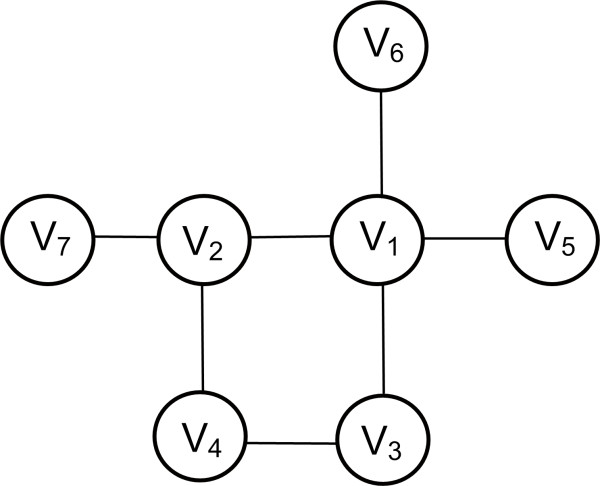
Eccentricity Centrality. V1: 4 × 1, 2 × 2; V1 accesses 4 nodes (V2, V3, V5, V6) with step 1 and 2 nodes (V4, V7) with step 2. The step represents the shortest path. The maximum shortest path dmax = 2. V2: 3 × 1, 3 × 2; Similarly V2 accesses 3 nodes (V4, V7, V1) with step 1 and 3 nodes (V3, V5, V6) with step 2. The maximum shortest path dmax = 2. V3: 2 × 1, 3 × 2, 1 × 3; Similarly V3 accesses 2 nodes (V1, V4) with step 1, 3 nodes (V2, V5, V6) and one node (V7) with step 3. The maximum shortest path dmax = 3. V4: 2 × 1, 2 × 2, 2 × 3; The maximum shortest path dmax=3. V5: 1 × 1, 3 × 2, 2 × 3; The maximum shortest path dmax = 3. V6: 1 × 1, 3 × 2, 2 × 3; The maximum shortest path dmax = 3. V7: 1 × 1, 2 × 2, 3 × 3; The maximum shortest path dmax = 3. As a result, the ordering of the nodes according to Cecc : (V1,V2), (V3,V4,V5,V6,V7).